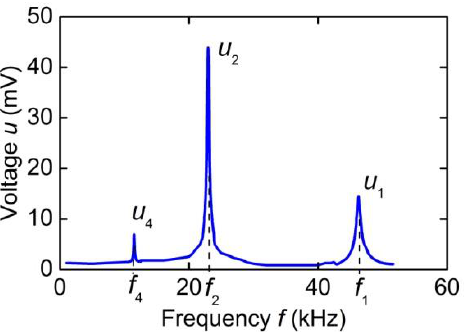
Figure 26. Dependence of ME voltage u on the current frequency f for the Metglas/PZT hetero- structure excited by a current flowing through the Metglas layer.